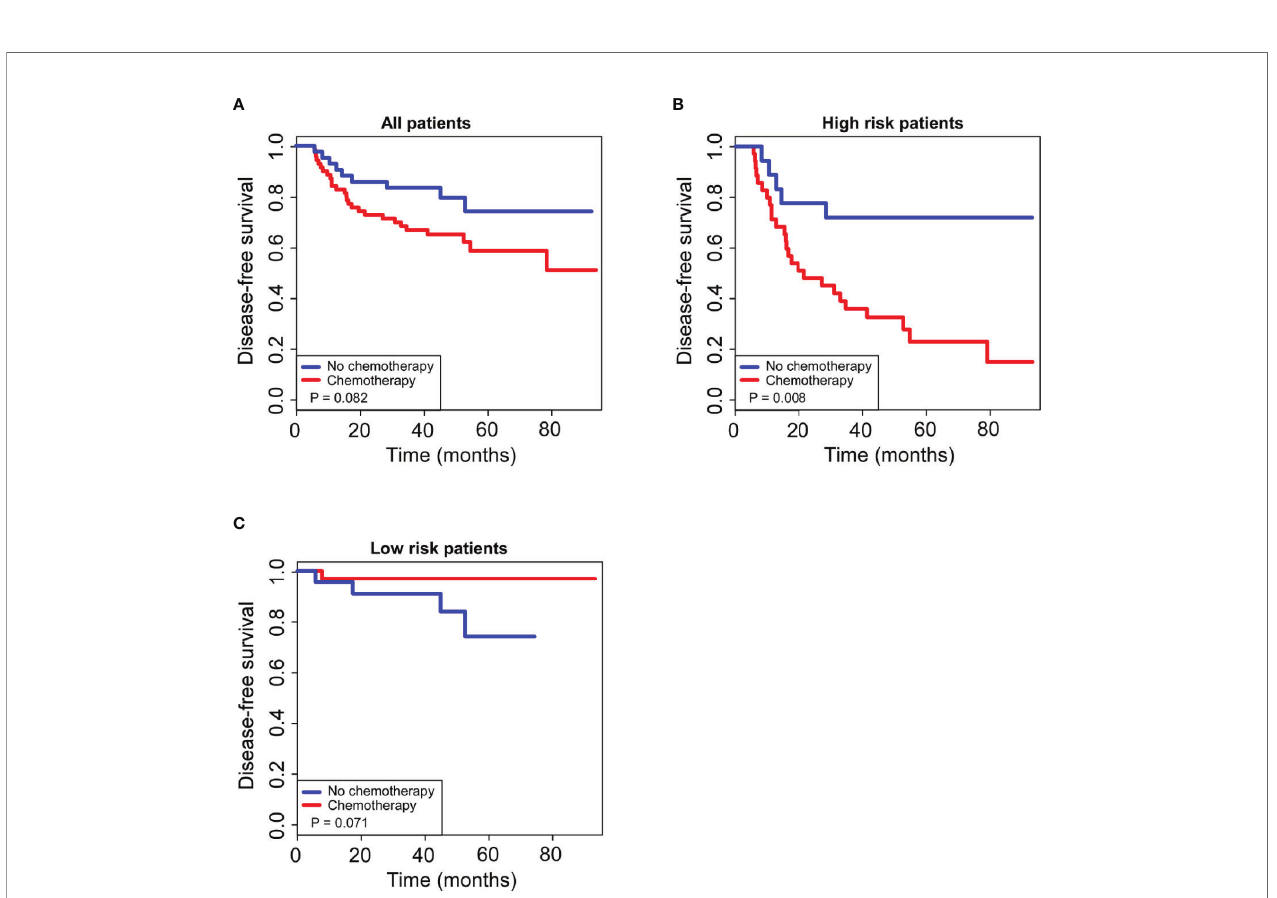
FIGURE 6 | Kaplan – Meiercurvesofpostoperativeadjuvantchemotherapyfor5-yearsurvivalinnon-pCRpatients.Forallpatientsenrolledinourstudy (A) ,postoperative adjuvantchemotherapyhadnosigni fi canteffecton5-yearDFS(P>0.05);forpatientsinthelow-riskgroupstrati fi edbytheradiomicsnomogram (B) ,postoperativeadjuvant chemotherapyhadnosigni fi canteffecton5-yearDFS(P>0.05);forpatientsinthehigh-riskgroupstrati fi edbytheradiomicsnomogram (C) ,postoperativeadjuvant chemotherapysigni fi